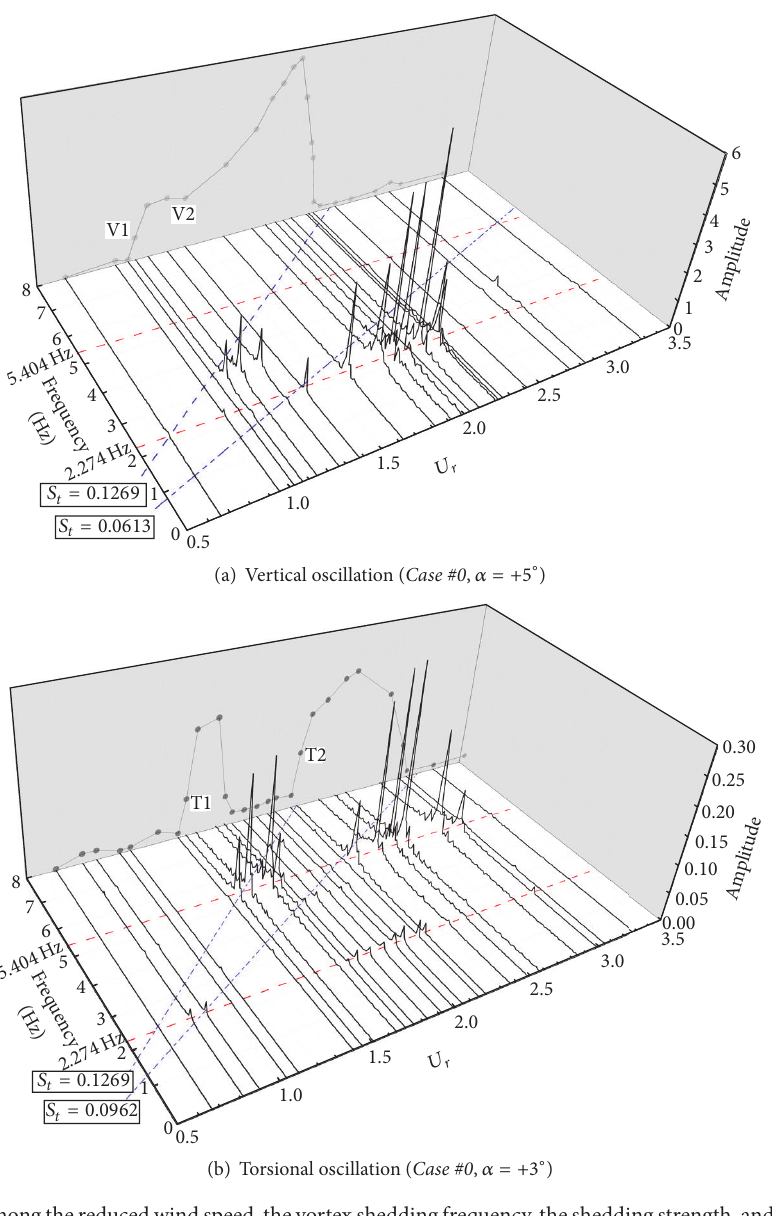
Figure 12: Relationships among the reduced wind speed, the vortex shedding frequency, the shedding strength, and the oscillation amplitude.